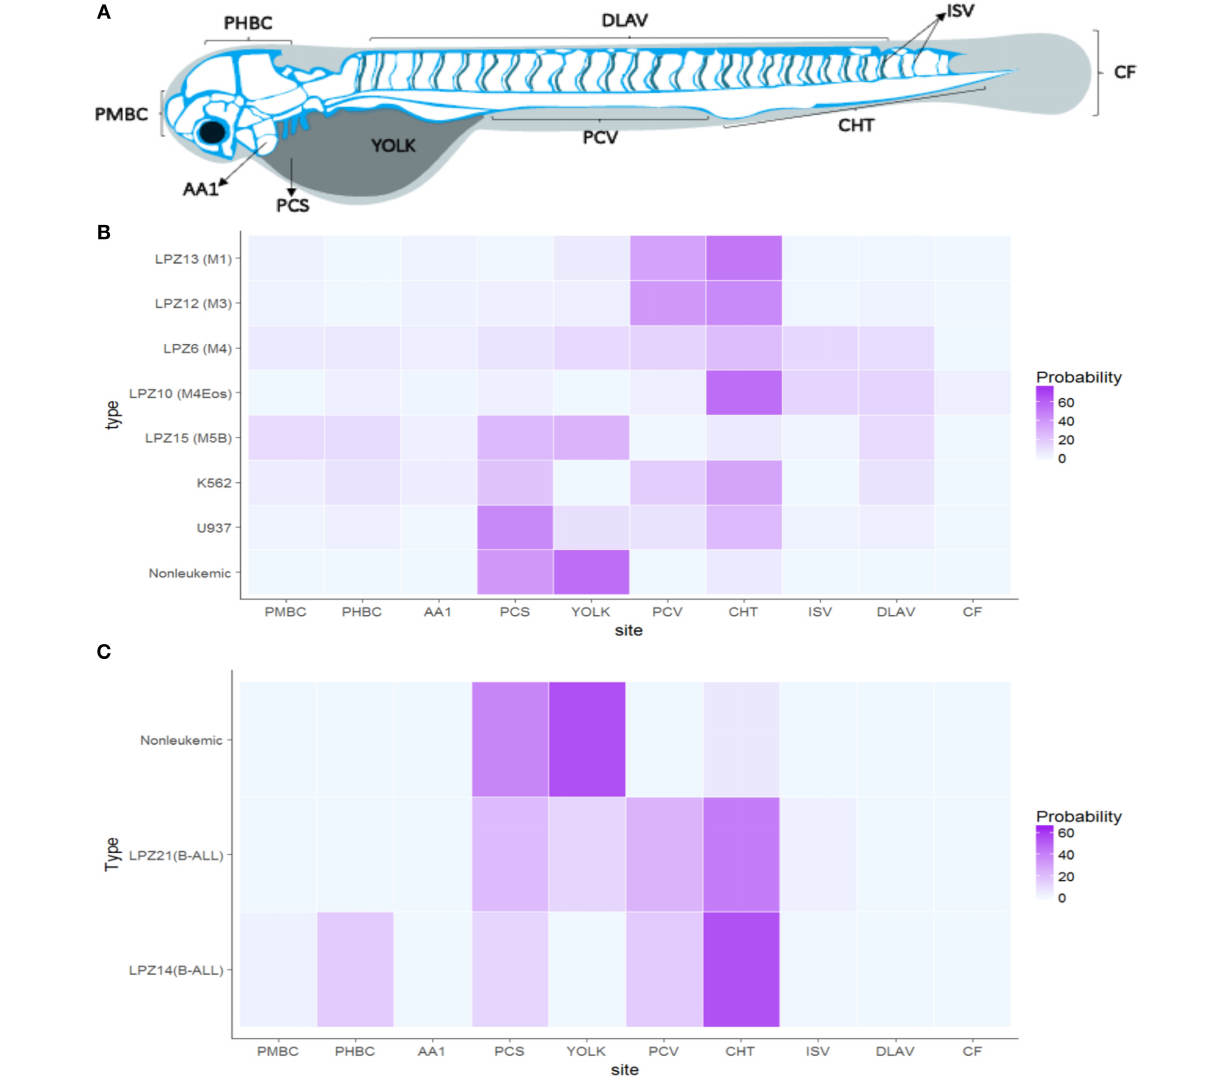
FIGURE 5 | Acute leukemia xengorafts tropism. Human cells exhibited a clear tropism toward the hematopoietic tissue of zebrafish embryos. (A) Anatomic migration regions based on zebrafish vasculature and hemodynamics. (B) Probability (%) heat map of AML xenografts. (C) Probability (%) heat map of ALL xenografts. Significant differences were determined based on Bayesian 95% Highest Density Interval. Pericardial space (PCS), Yolk, Caudal Hematopoietic Tissue (CHT), Caudal Fin (CF), Intersegmental veins (ISV), Primordial Hindbrain Channels (PHBC), Posterior Caudal Vein (PCV), Primordial Midbrain Channel (PMBC), and Dorsal Longitudinal Anastomotic Vessel (DLAV) ( n = 24 embryos per cell